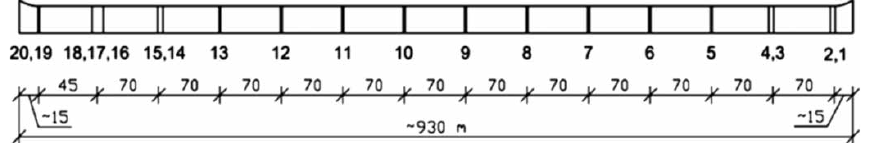
Fig. 7. Measuring places in tested tunnel